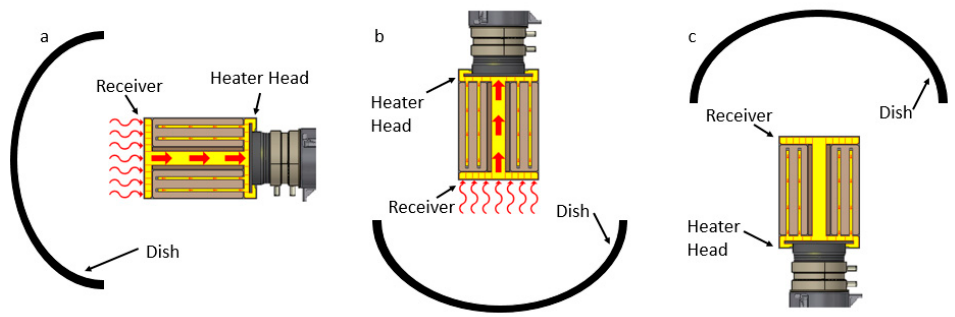
Figure 4. TES module orientations studied: ( a ) gravity-neutral horizontal charging; ( b ) mid-day vertical